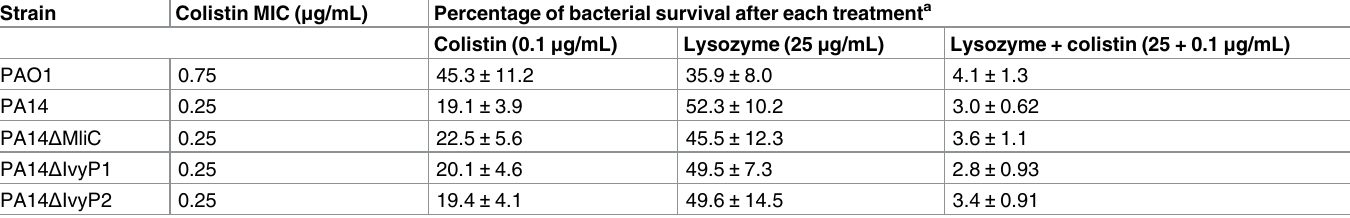
Table 1. Susceptibility to colistin, lysozyme and combined treatment (lysozyme+colistin) of PAO1, PA14, and PA14-derived transposon knockout mutants in the lysozyme inhibitory proteins MliC, IvyP1 or its paralog IvyP2. Strain